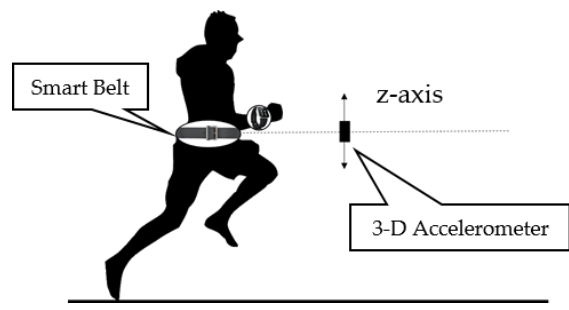
Figure 8. Accelerometer shaking when the user is running. Table 2. Classification rules for user movements.